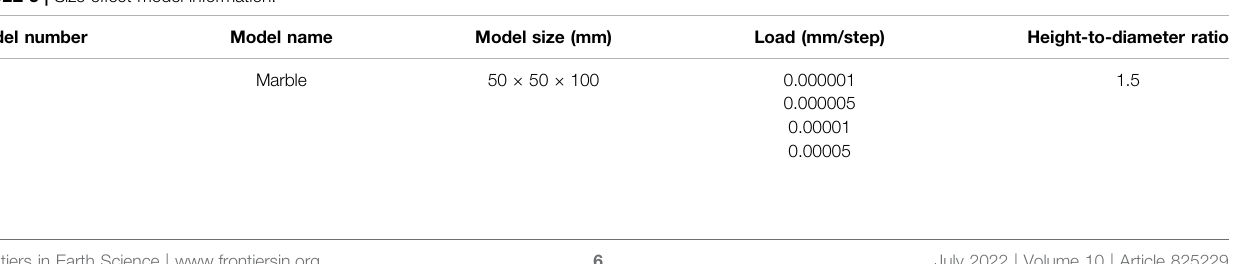
TABLE 3 | Size effect model